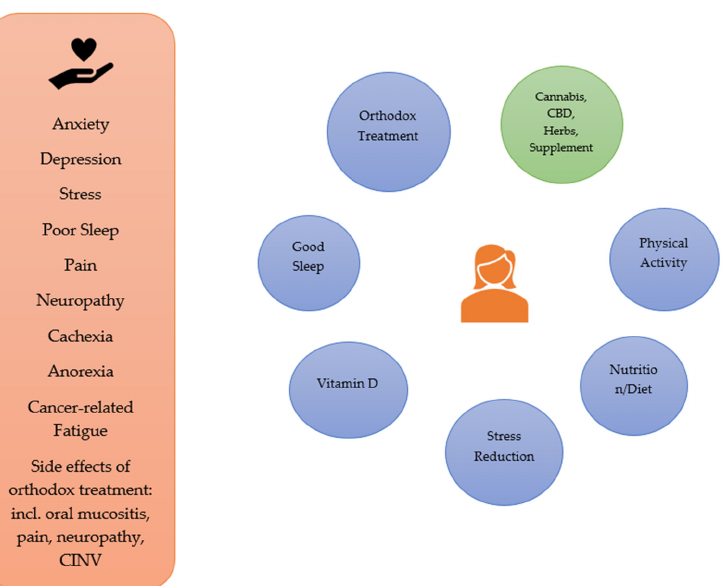
Figure 1. Integrative Approaches to the Symptoms/Signs Associated with Cancer and its Orthodox